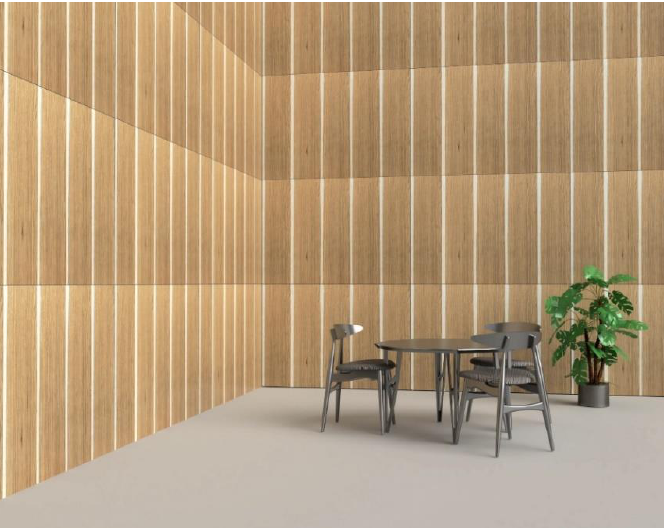
Figure 3. 3D visualization example of decorative wall panel from veneer residue joined by sewing, type A (© Domagoj Mamić, 2022).